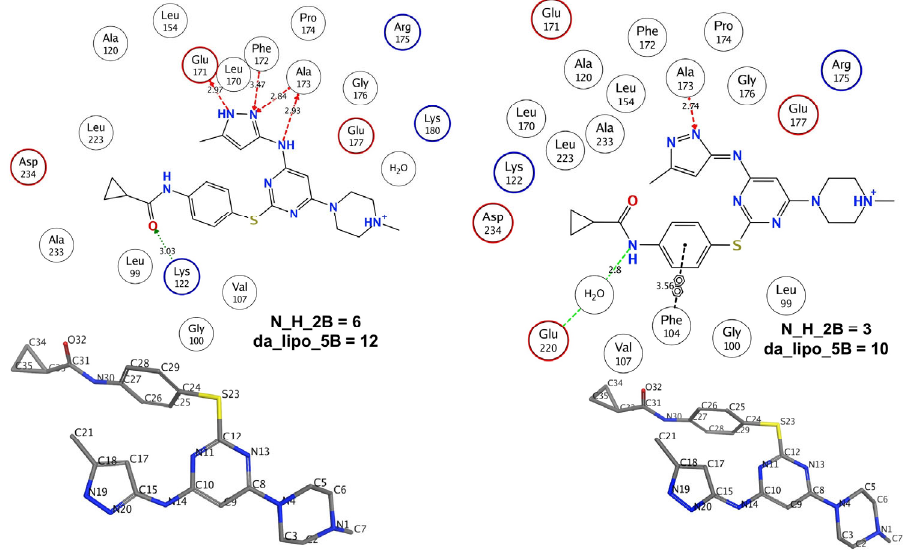
Figure 5. Pictorial representation of N_H_2B using VX-680 (pdb 4b8m) as an example. Table 2. Distances of different atoms of TA and TB forms of VX-680 (molecule number 14) from the receptor atoms (pdb 4b8m).